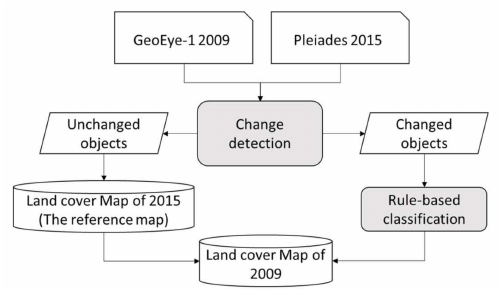
Figure 3. Flowchart of land cover classification using backdating. The key steps were highlighted in